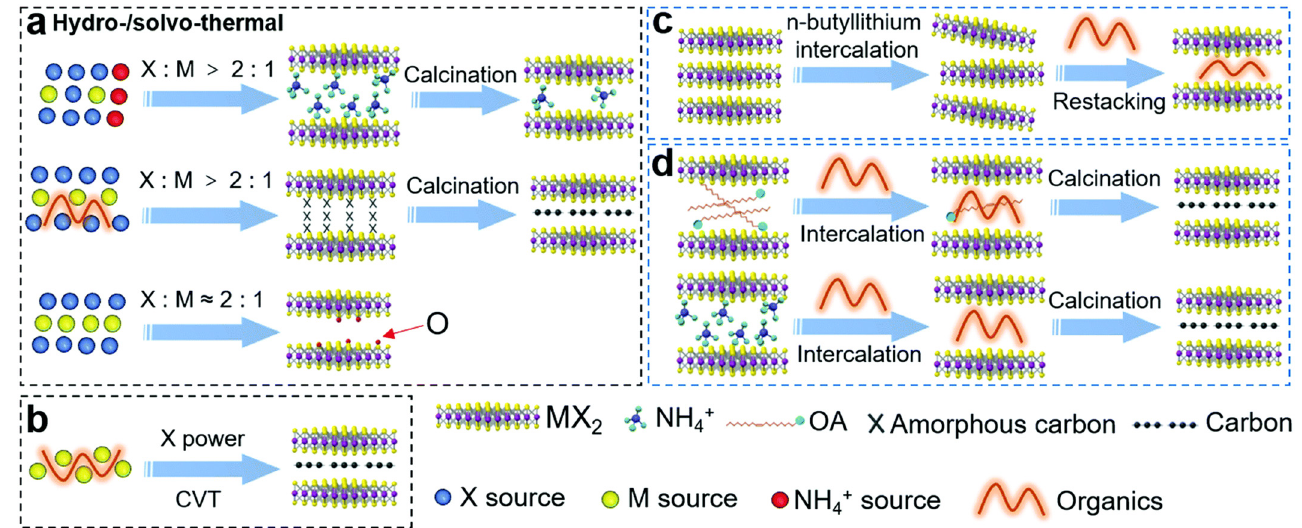
Figure 5. Schematic illustrations of methods for synthesis of the interlayer-expanded MX 2 . ( a ) hydro-/solvo-thermal; ( b ) chemical vapor transport (CVT); ( c ) exfoliation–restacking; ( d ) template intercalation method. Reproduced with permission of ref. [32]. Copyright 2020. Royal Society of Chemistry.